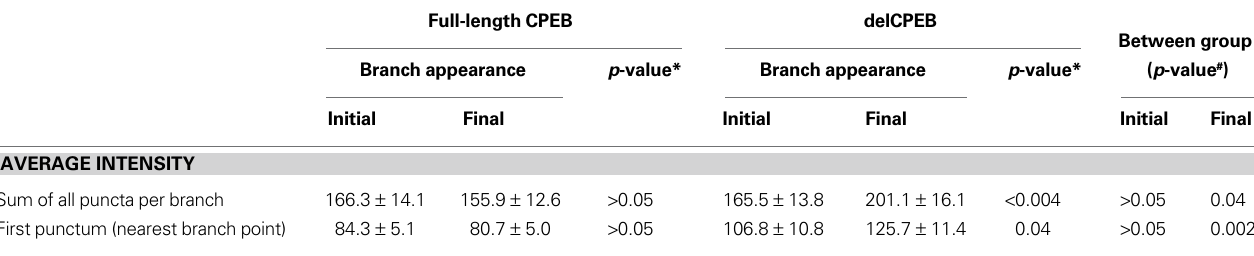
Table 4 | Changes in punctum